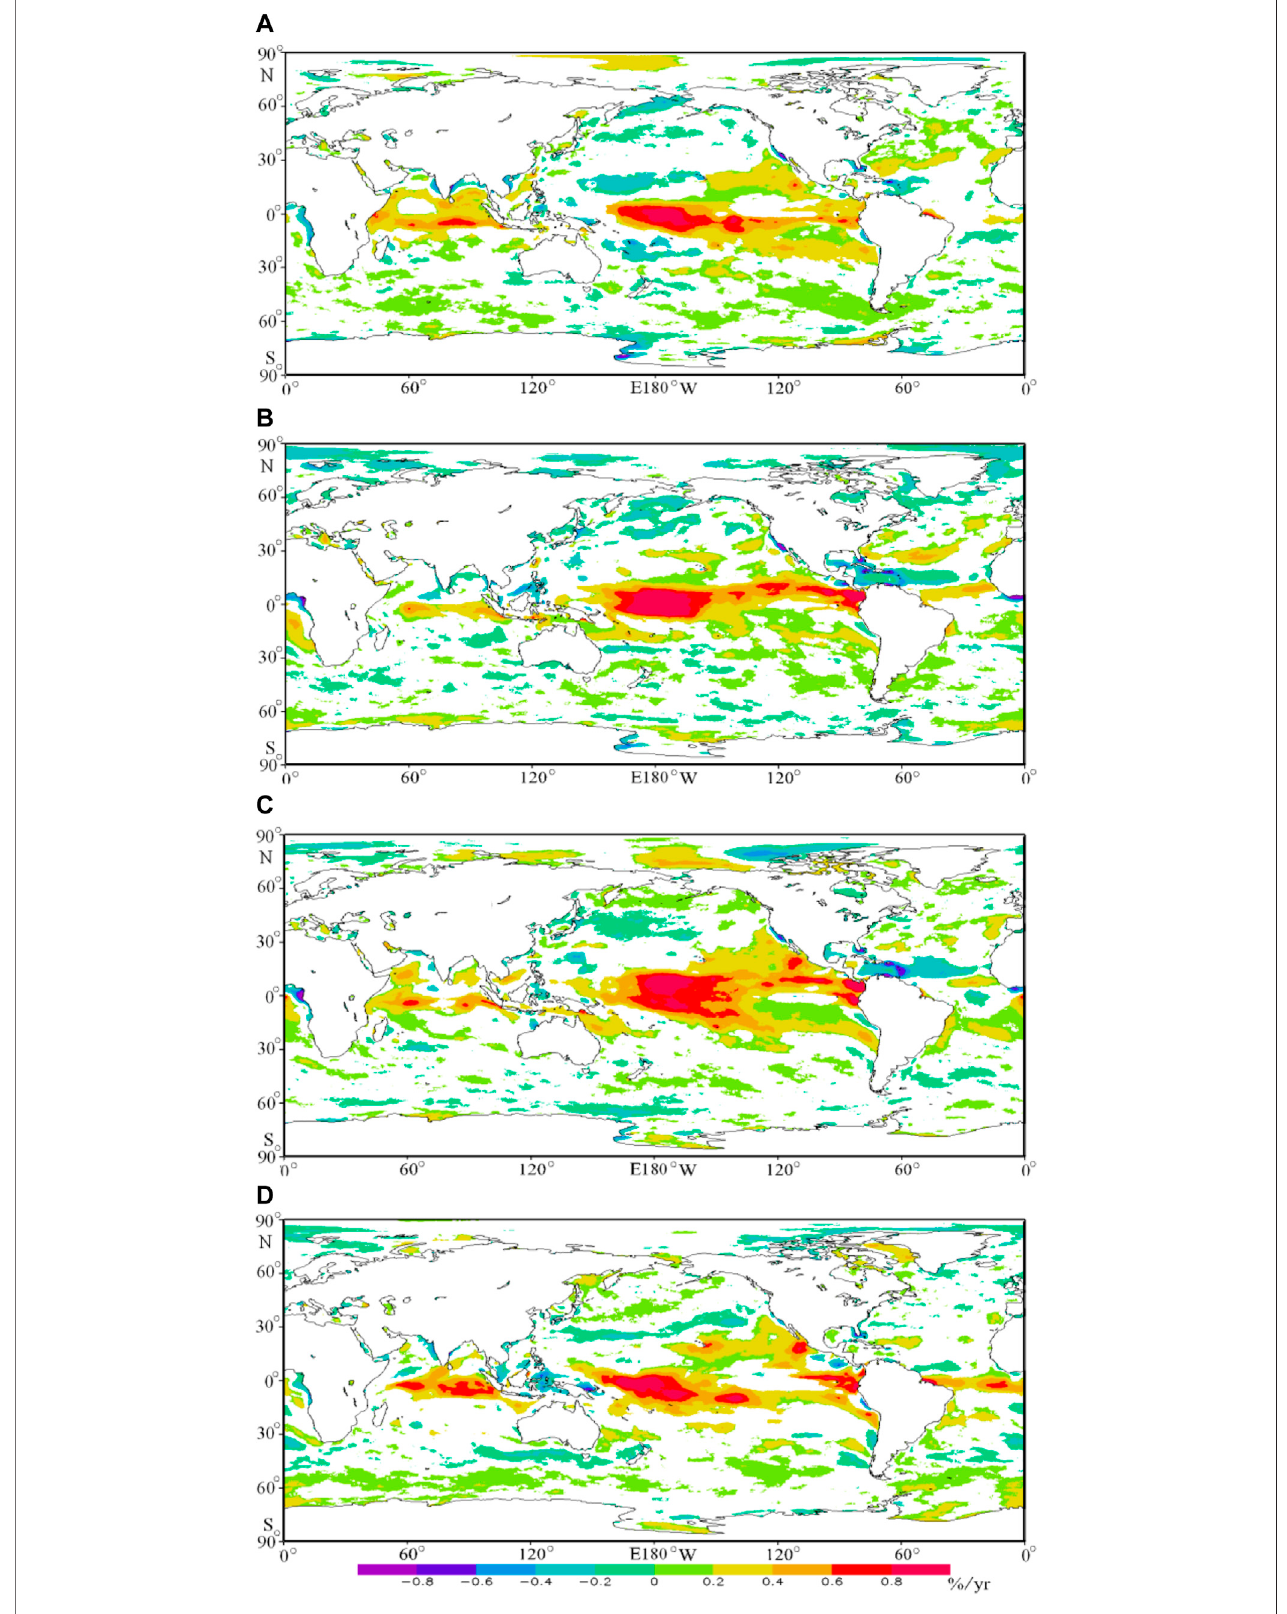
FIGURE 7 | Long-termtrendsoftheeffectivewindspeedoccurrenceinMAM (A) ,JJA (B) ,SON (C) ,andDJF (D) intheglobalocean.Onlyareasigni fi cantat95%levelispresented.